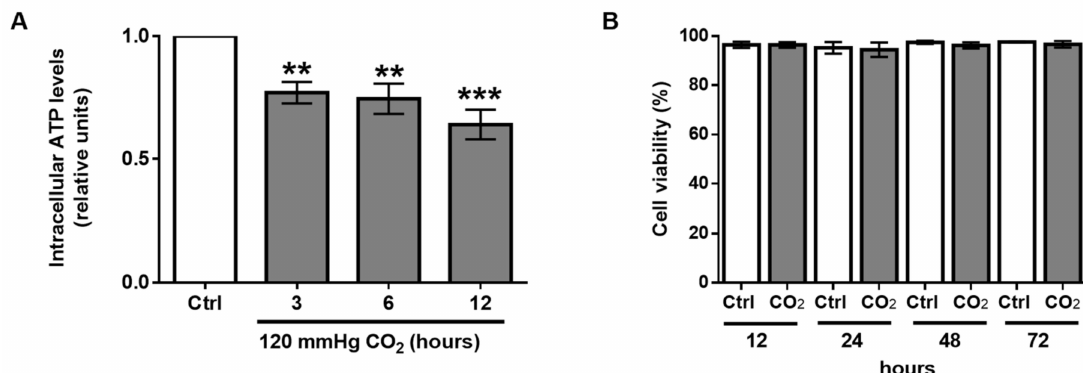
Figure 5. Hypercapnia decreases intracellular ATP production but does not a ff ect cell viability. ( A ) A549 were treated with normal (Ctrl, 40 mmHg, pHe = 7.4) or elevated CO 2 levels (CO 2 , 120 mmHg, pHe = 7.4) for di ff erent time-points. Intracellular ATP levels were measured by using an ATP bioluminescence assay kit. Bars represent total ATP / total protein ratio. Values are expressed as mean ± SD ( n = 3, ** p < 0.01, *** p < 0.001). ( B ) A549 cells were exposed to normal (Ctrl, 40 mmHg, pHe = 7.4) or elevated CO 2 levels (CO 2 , 120 mmHg, pHe = 7.4) for di ff erent time-points. Cell viability was measured by assessing the plasma membrane integrity. Graph bars represent the percentage of viable cells. Values are expressed as mean ± SD ( n =